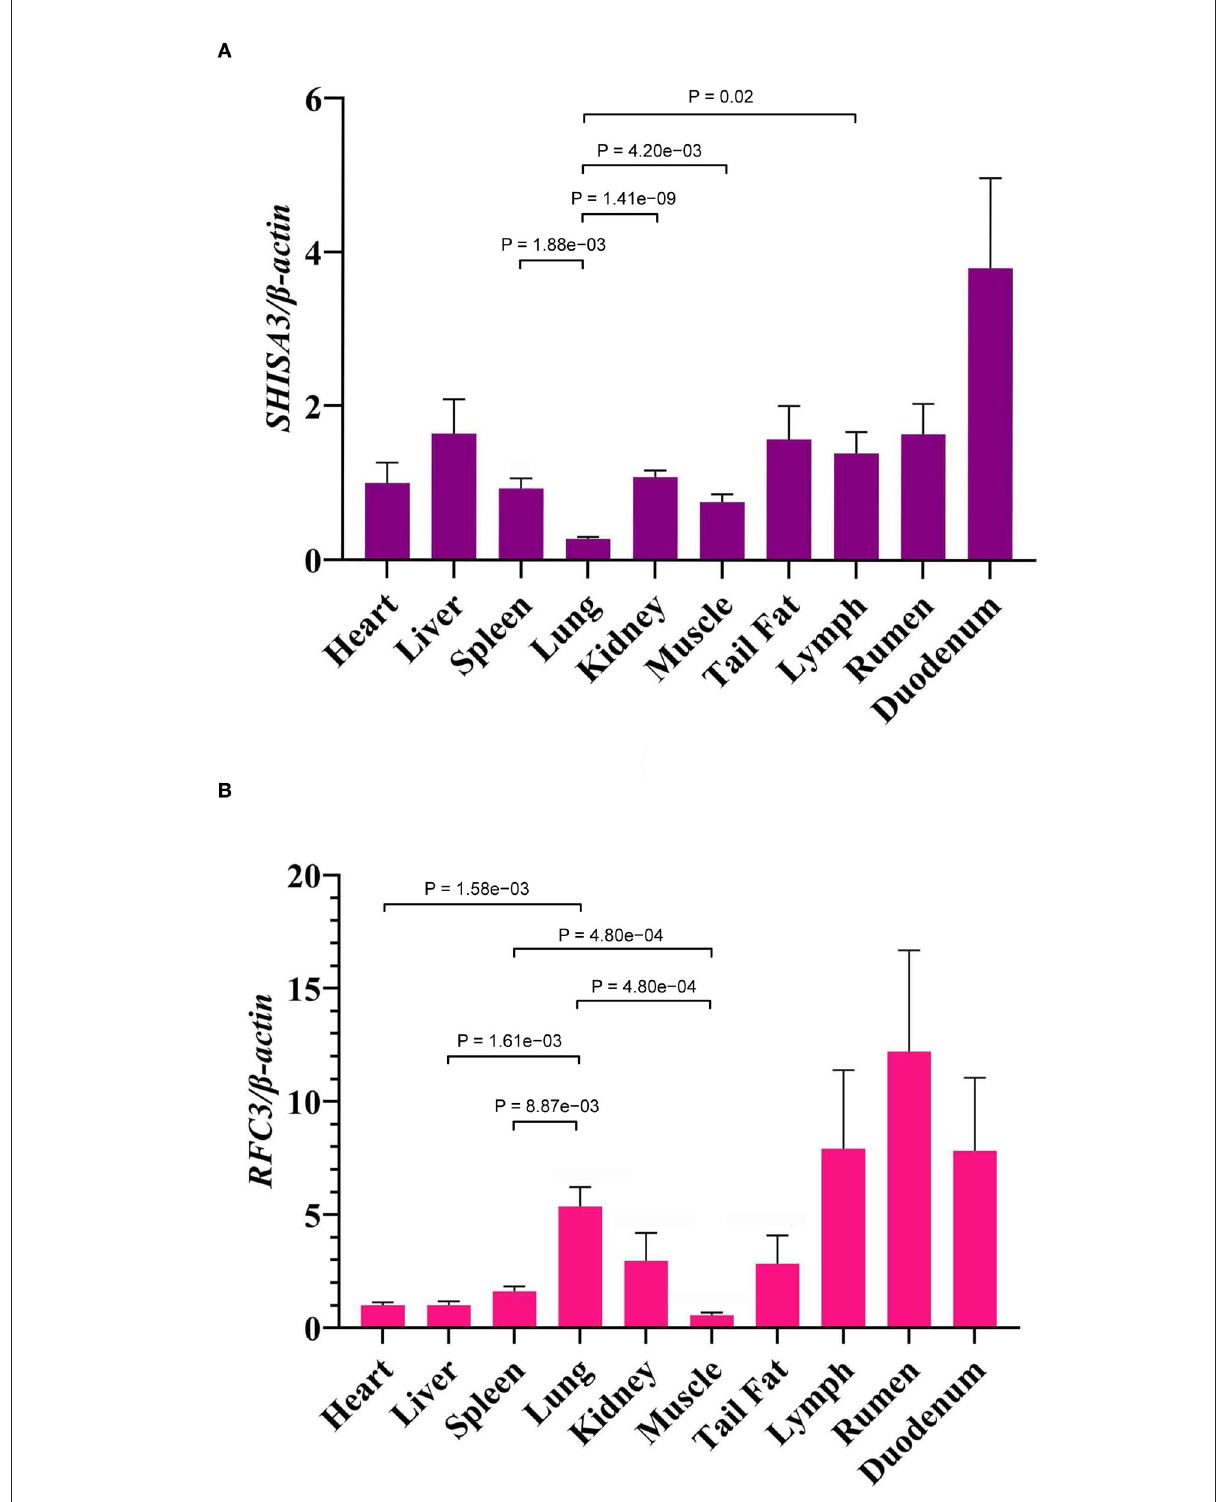
FIGURE4 The expression of SHISA3 mRNA in different tissues (A) . The expression of RFC3 mRNA in different tissues (B) .